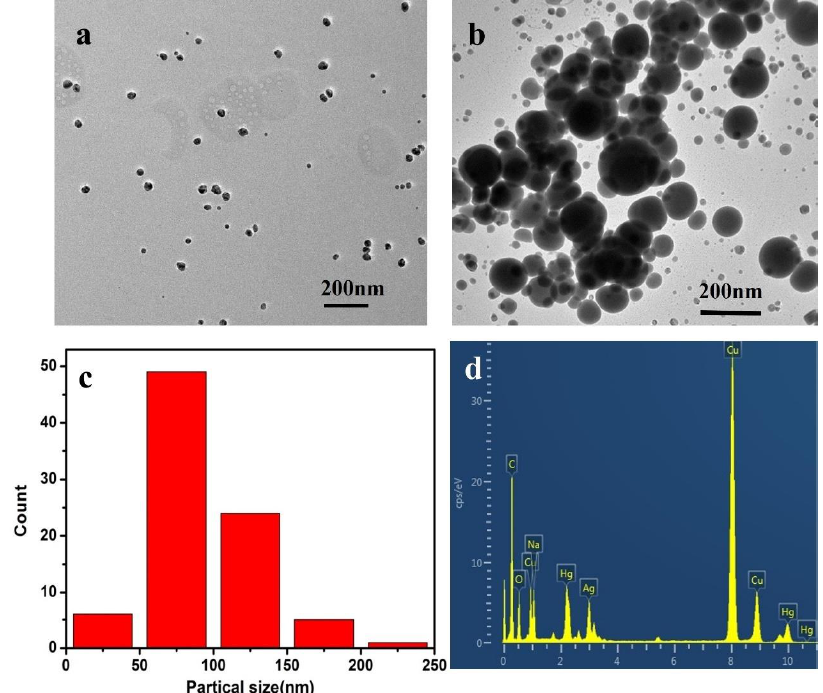
Figure 6. ( a ) TEM of the CMS/PVP-Ag NPs colloidal solution in the presence of Hg 2+ (30 µ M), ( b ) TEM of the CMS/PVP-Ag NPs colloidal solution after the addition of Hg 2+ can induce the formation of Ag – Hg amalgam ( c ) size distribution, and ( d ) EDS spectrum of CMS/PVP-Ag NPs with the addition of Hg 2+ . TEM was conducted to explore the morphology variation of the CMS/ PVP-Ag NPs sol when the Hg 2+ was introduced. Figure 7a presents the image of CMS/PVP-Ag NPs with Hg 2+ , and Figure 7b and c reveals the existence of mercury and silver elements in the CMS/PVP-Ag NPs, respectively. A superimposed image of mercury and silver are shown in Figure 7d. It can be observed that the composites are hybridizing with each other, and adding Hg 2+ into the CMS/PVP-Ag NPs can increase the size of Ag NPs to form a large cluster.